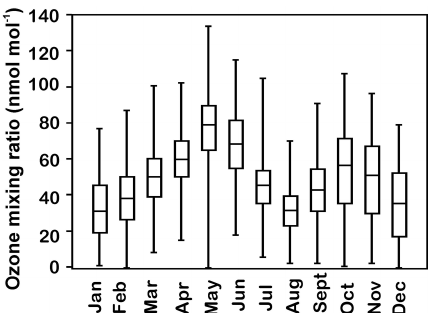
Figure 2. Seasonal box-and-whisker plot of the 1h average day- time (08:00–19:59LT) ozone mixing ratios. Whiskers denote the monthly minimum and maximum value, the box represents the up- per and lower quarter value and the horizontal line within the box represents the median.